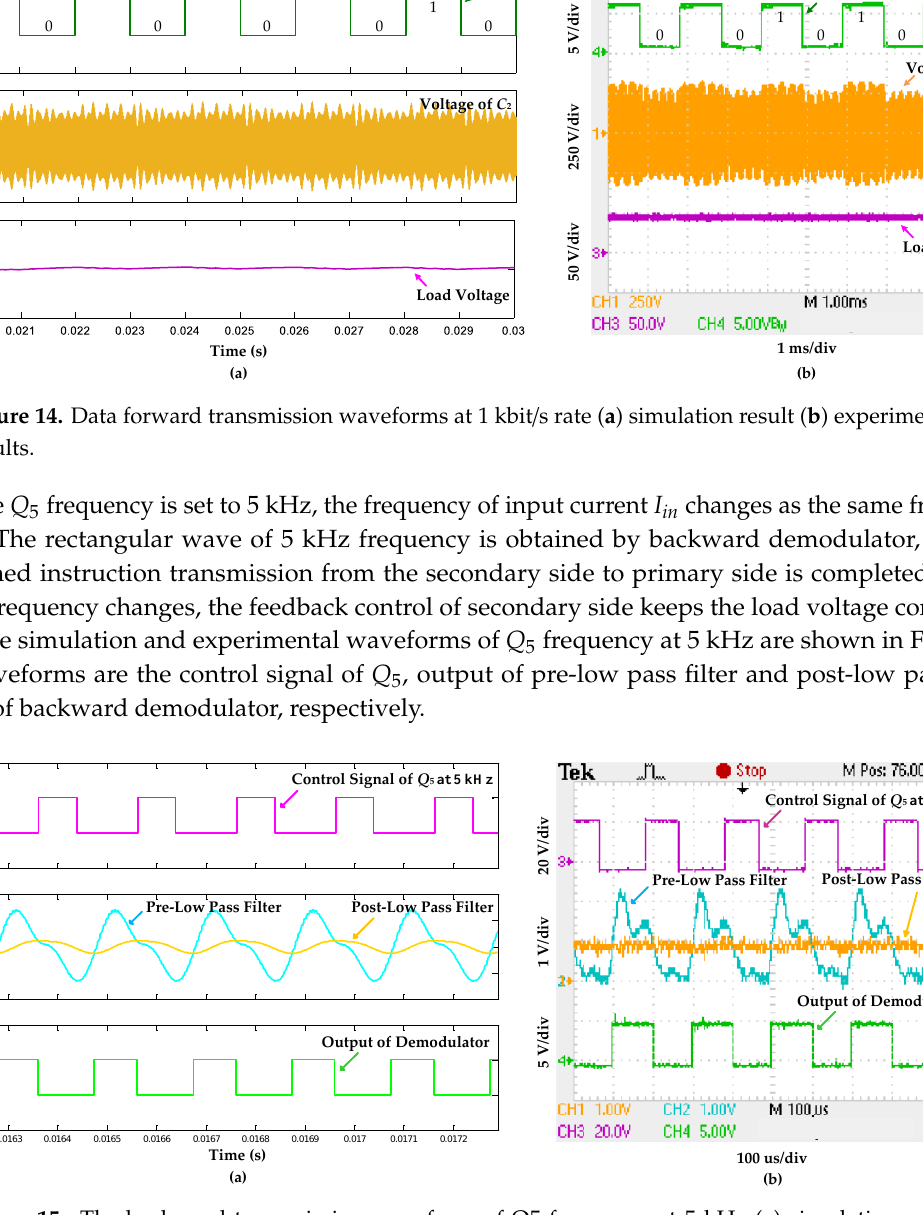
Figure 15. The backward transmission waveform of Q5 frequency at 5 kHz ( a ) simulation result ( b ) experimental result.